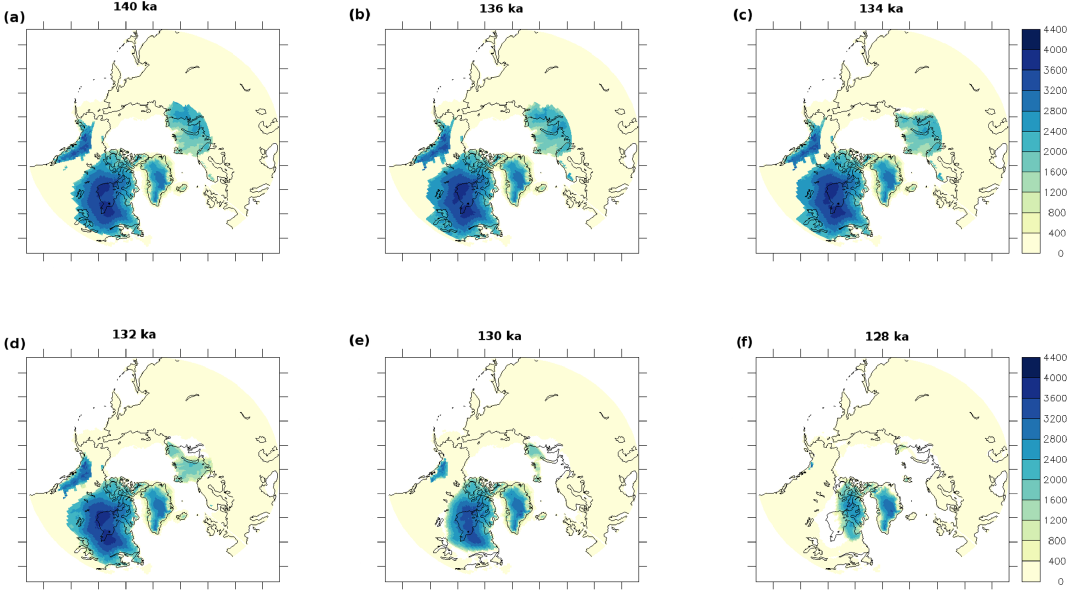
Figure 3. NH ice-sheet elevation (m) at (a) 140, (b) 136, (c) 134, (d) 132, (e) 130 and (f) 128ka from the combined ice-sheet forcing as simulated by the IcIES-MIROC model (Abe-Ouchi et al., 2013) for the North American and Eurasian ice sheets and as simulated by the Glacial Systems Model (GSM) (e.g. Tarasov et al., 2012) for the Greenland ice sheet. Elevation is shown where the ice mask is greater than